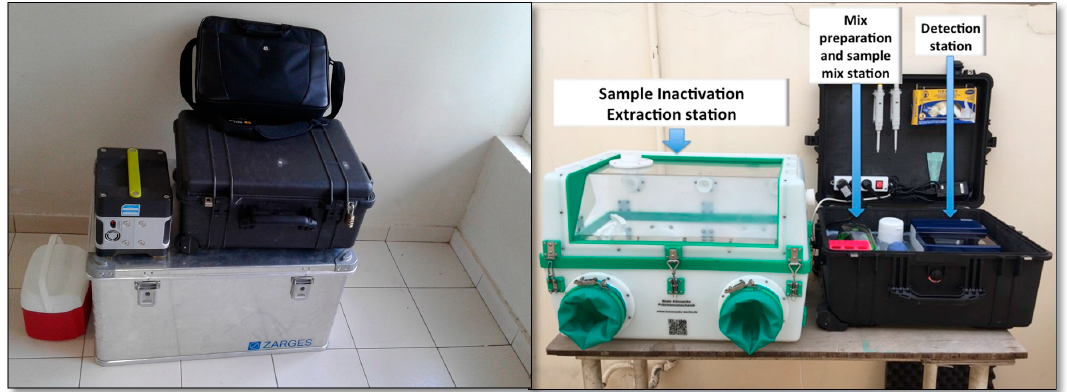
Figure 2. Deployment of the mobile laboratory at the Institut Pasteur de Dakar before departure ( left ), and at the site of study, Medina Gounass ( right ). For more detail on the extraction procedure, see Figure 2 in [11].